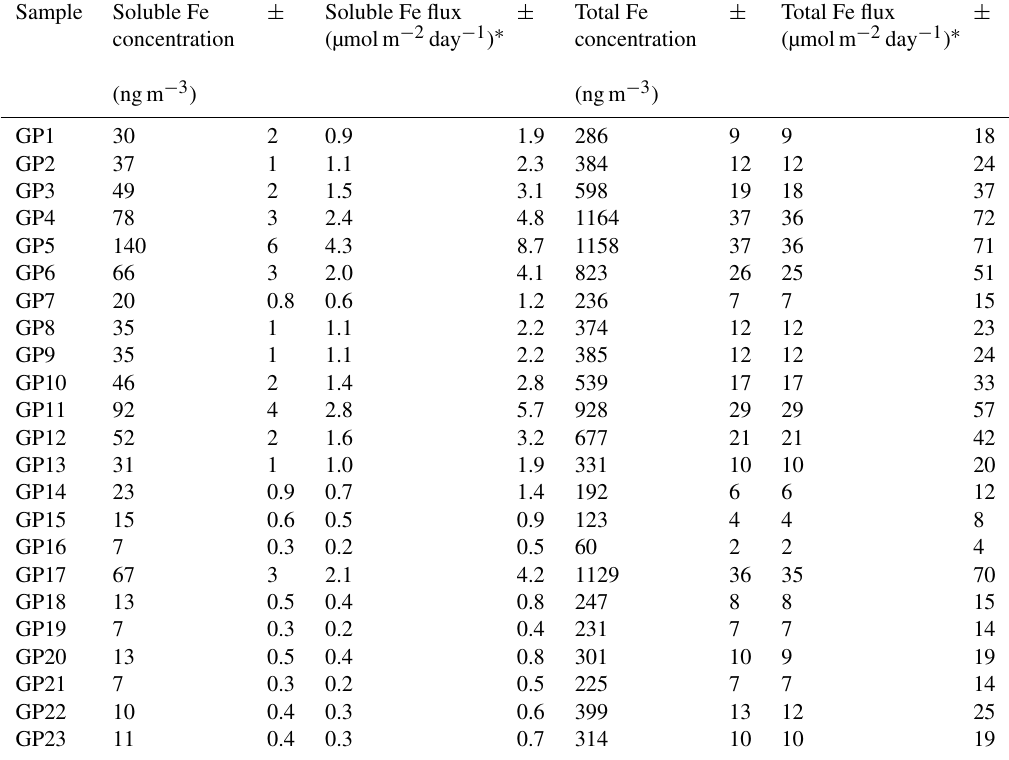
Table 1. Aerosol iron concentrations and dry deposition fluxes for Gunn Point PM 10 aerosols.